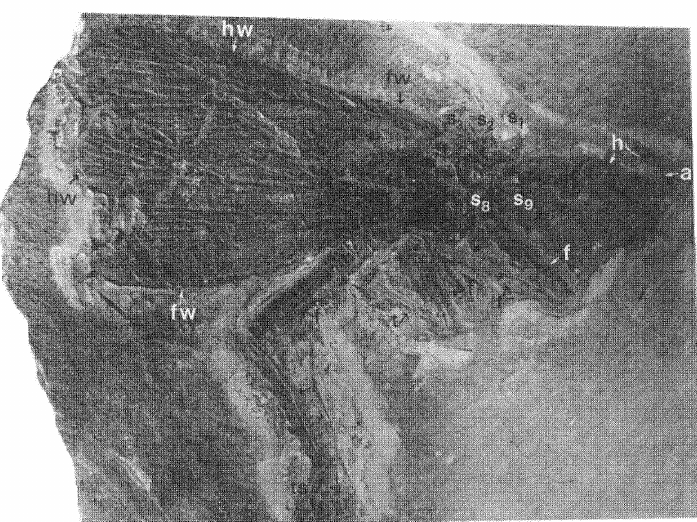
Fig. 15. Gerarus.I’ischeri, photograph of holotype, IP 5. Total length 75 mm. spine; h head; a antenna, femur; tibia; ts tarsomere; fw fore wing; hw hind